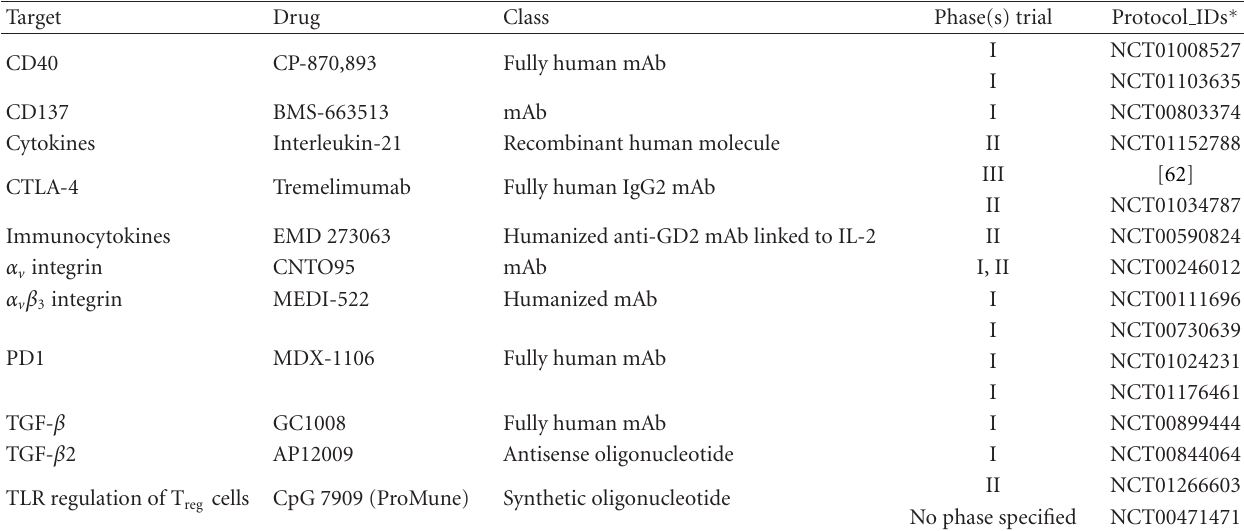
Table 3: Emerging immunotherapeutic to treatment of metastatic